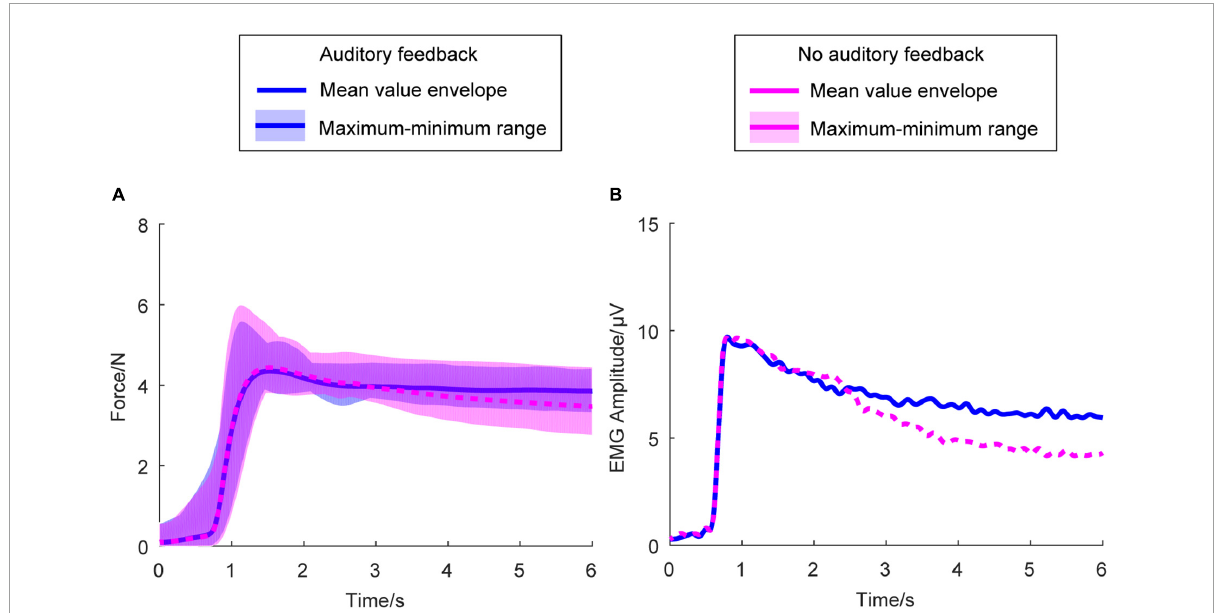
FIGURE3 Average force envelope and average EMG amplitude in all the participants ( N = 17) and two conditions. In (A) , the horizontal axis means the time, the vertical axis means the force amplitude. In (B) , the horizontal axis means the time, the vertical axis means the EMG amplitude. The transparent area means the maximum and minimum range of the mean force exerted force of each participant across all the participants at every sampling point. The blue solid line means the mean value envelope across all the participants in the auditory feedback condition, the magenta dashed line means the mean value envelope across all the participants in the no auditory feedback condition. EMG,